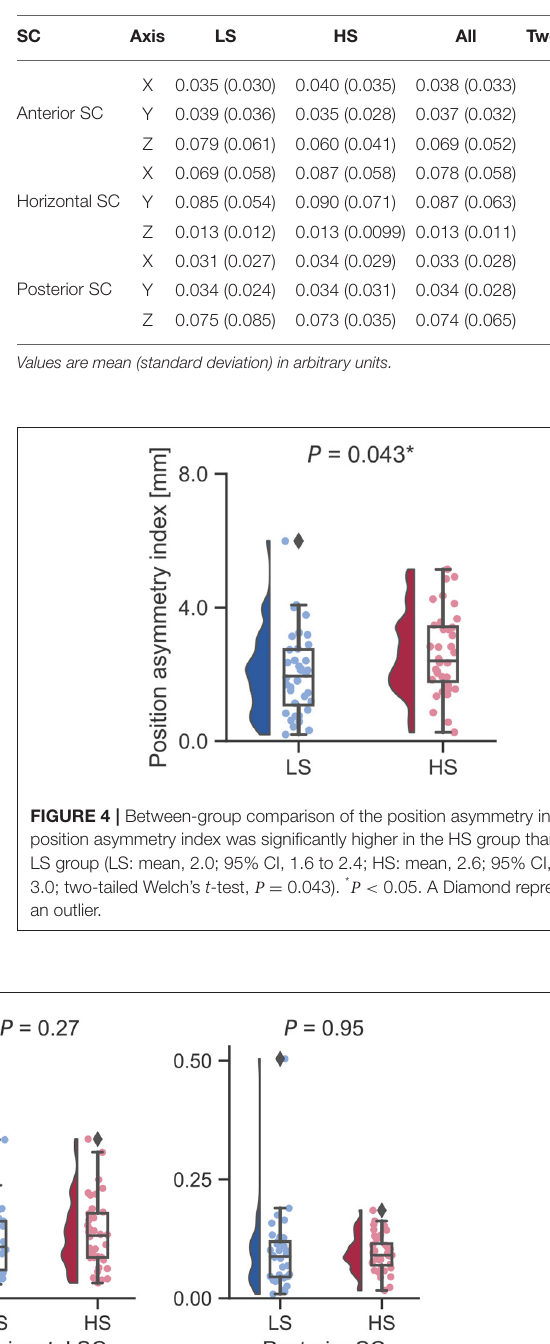
TABLE 3 | Orientation asymmetry index in each axis.